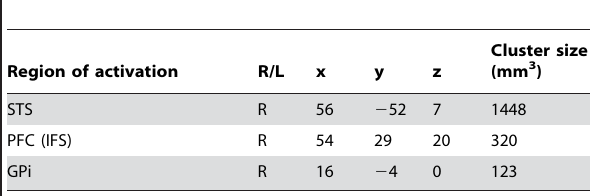
Table 1. Talairach coordinates and voxel cluster size values for the main effect of emotion (FDR ,